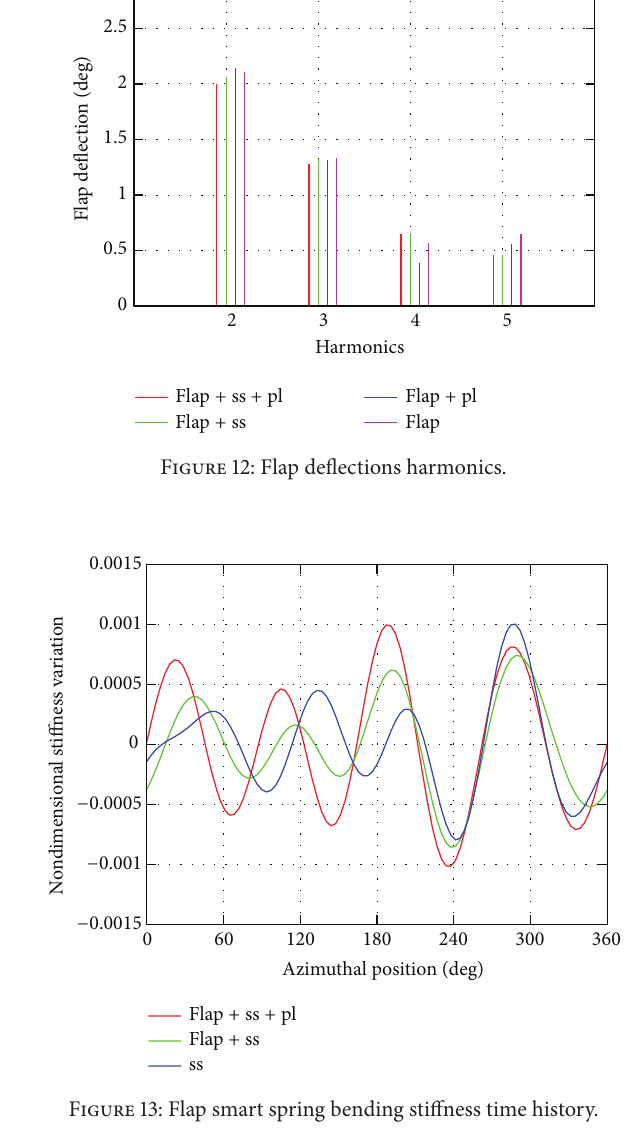
Figure 13: Flap smart spring bending stiffness time